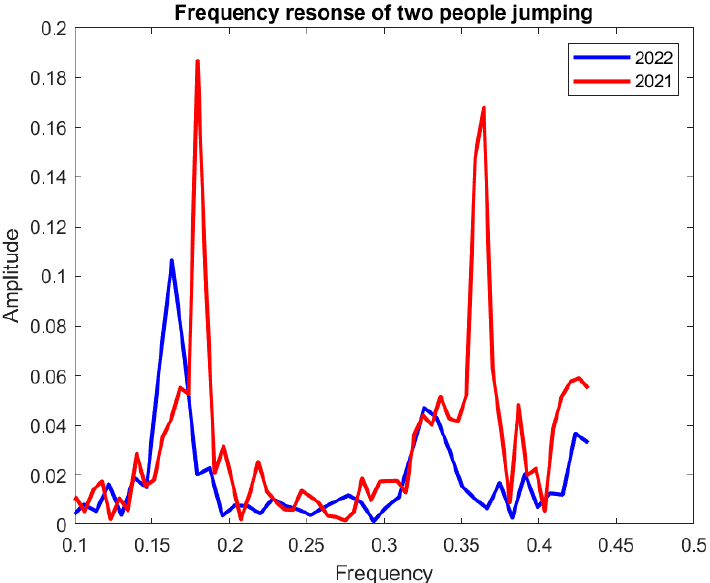
Figure 9. Comparison of two years’ sensor response for two people jumping.